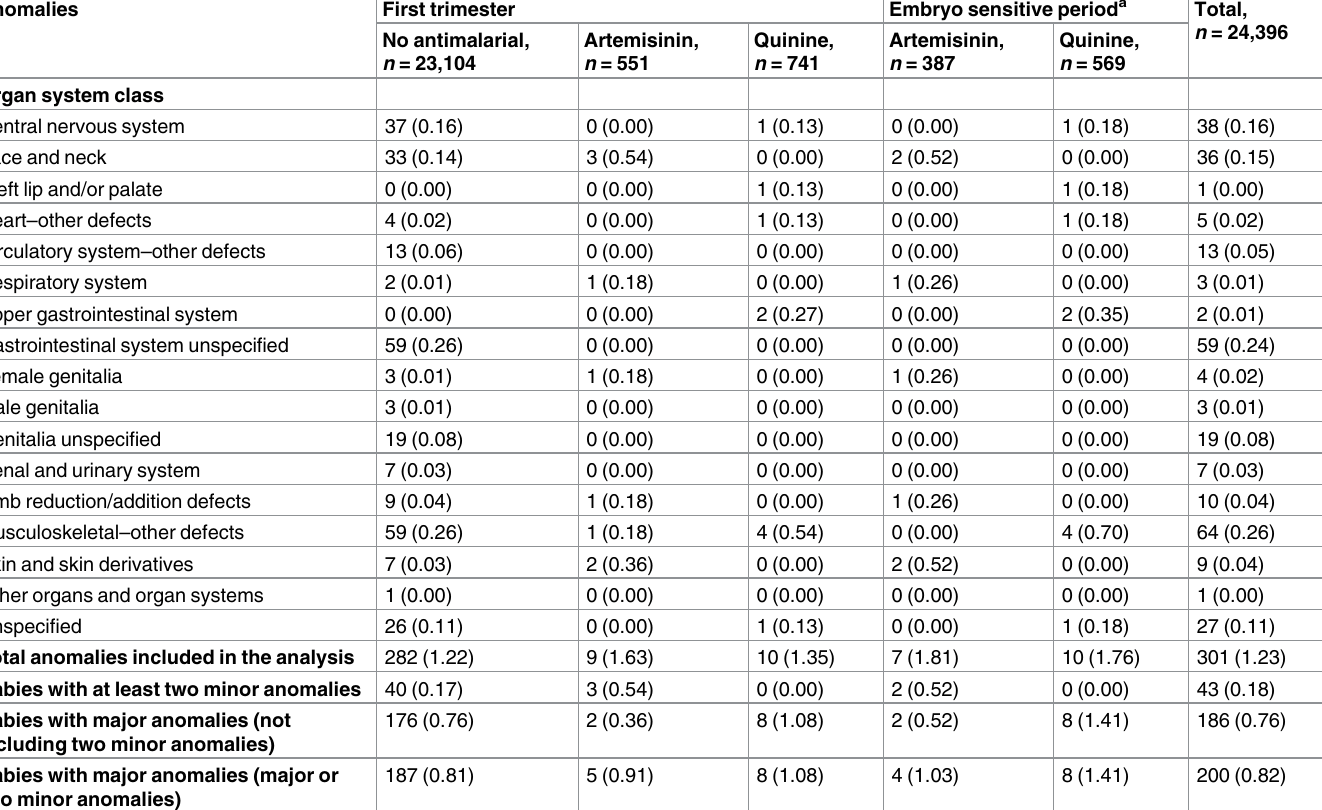
Table 3. Summaryof the distribution of minor and major congenital anomalies by Antiretroviral Pregnancy Registry Organ System Classification across exposure